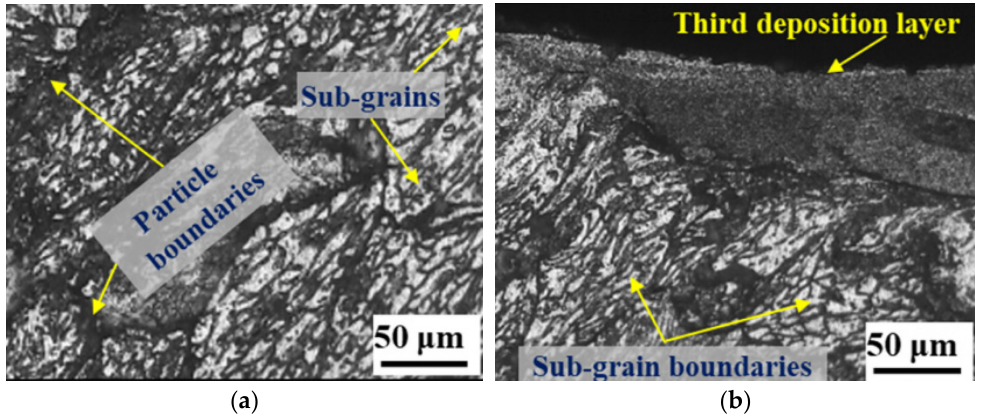
Figure 12. The non-uniform sub-grain distribution at different deposition layers of AA6061. ( a ) 1st deposition layer (sub-grain size: 9.3 μ m). ( b ) 3rd deposition layer (sub-grain size: 6.1 μ m).